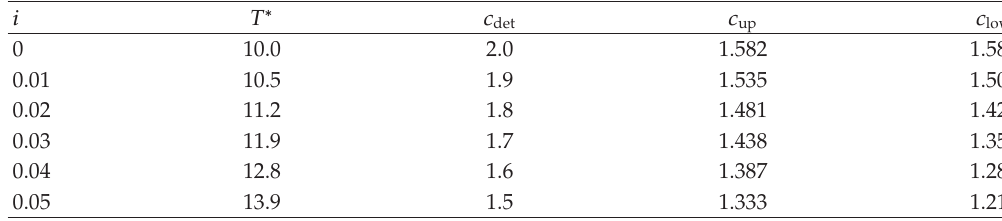
Table 1: Values of T ∗ ,c det ,c up ,c low for di ff erent i ’s (cid:3) P (cid:8) 10000 ,a (cid:8) 1000 (cid:4)